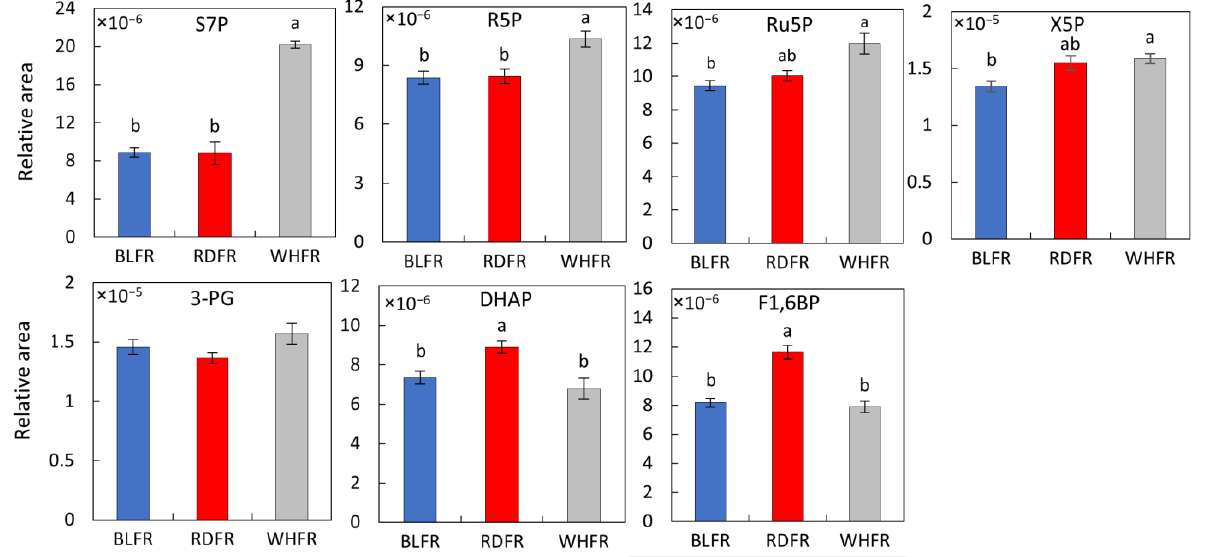
Figure 10. Transcriptomic profiles of carbon fixation (red), reduction (blue), and regeneration phase (green) and metabolic profiles of the Calvin cycle. Significant differences and >2 FC were found in the transcription level of PRK , FBP (Gene ID: 101260852), FBA3 , and GAPDH in BLFR vs. RDFR. Significant differences and >2 FC were found in the transcription level of PRK , FBP (Gene ID: 101260852), GAPDH , SBP , and TKL (Gene ID: 101245299) in BLFR vs. WHFR. Significant differences and >2 FC were found in the transcription level of rbcL in RDFR vs. WHFR. Red and blue rectangles indicate higher and lower levels, respectively, than the mean of all treatments. Values indicate the z-score in the legend. Sedoheptulose 7-phosphate (S7P), ribose 5-phosphate (R5P), ribulose 5-phosphate (Ru5P), xylulose 5-phosphate (X5P), 3-phosphoglyceric acid (3-PG), dihydroxyacetone phosphate (DHAP), and fructose 1,6-diphosphate (F1,6BP) concentration in fruits treated with different light treatments. Values indicate the mean ± SE ( n = 3). Different letters indicate significant differences at p < 0.05 by an independent t -test. BLFR, RDFR, and WHFR refer to blue, red, and white light-treated fruits,